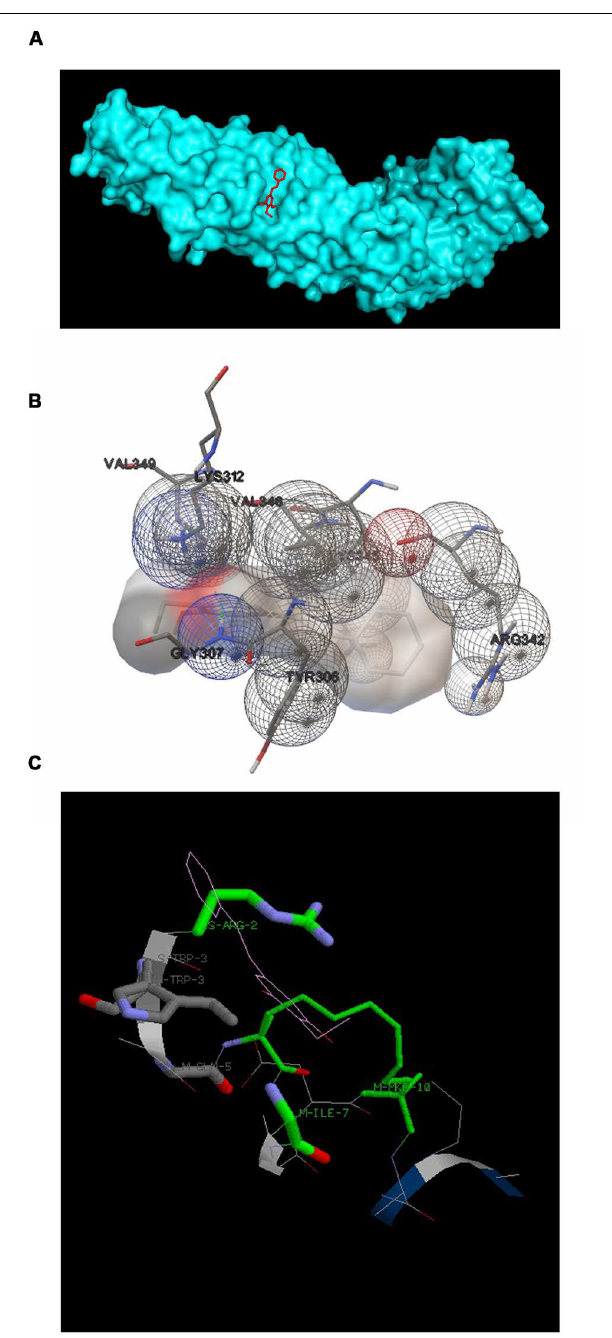
FIGURE 9 | Docking configurations of DETS in to β -catenin. Docking simulation was performed to identify interaction between DETS in to β -catenin using the Software: Autodock 4.2 and iGEMDOCKv2.1 (A) and (B) Docking modes of DETS on β -catenin using Autodock 4.2. (C) The best docking pose of DETS to β -catenin using iGEMDOCK.